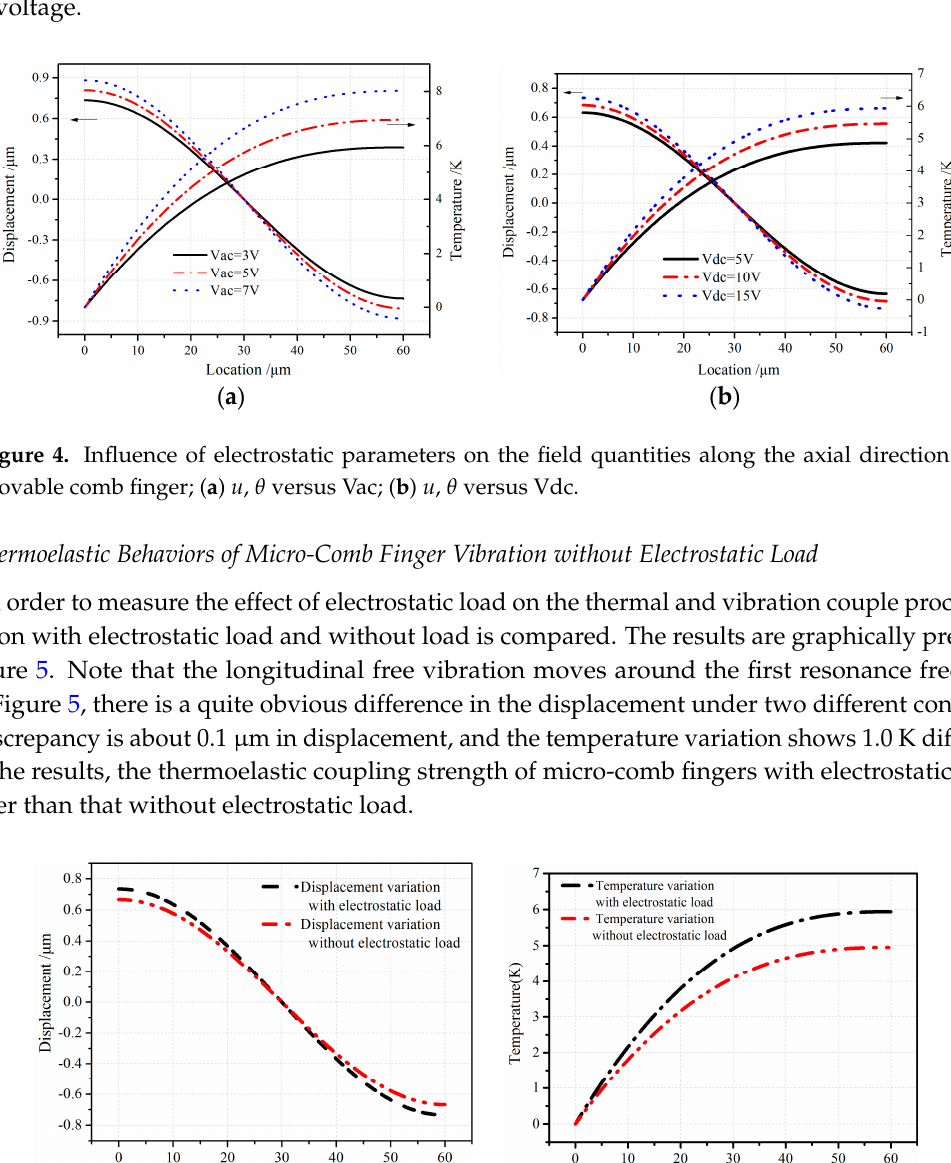
Figure 3. Displacement and temperature variation for different values of vibration width t is 0.01 µs, 0.02 µs and 0.03 µs.